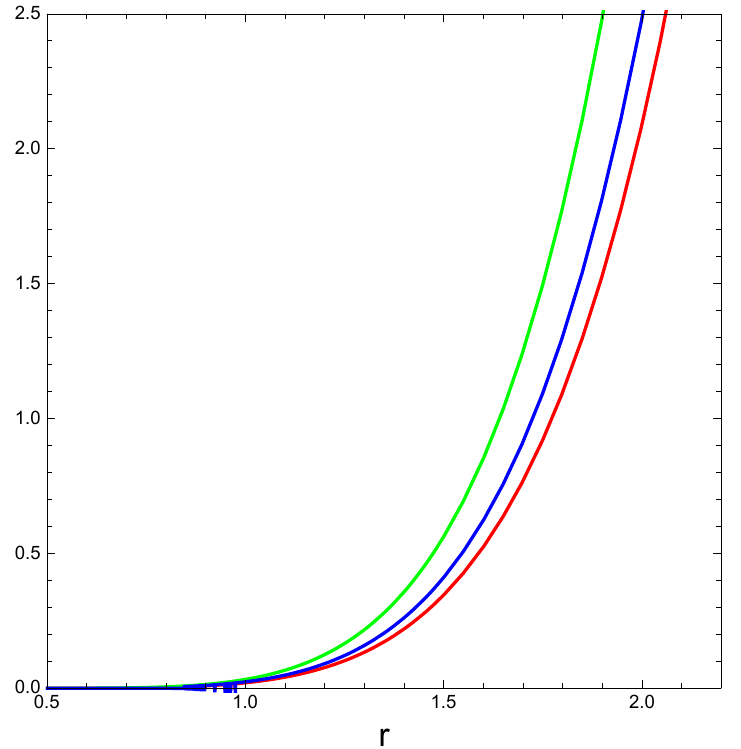
Figure 4. Solution of f ( R ( r )) for R is expressed as an exponential function of radius. The evolution of Equation (8) under f ( R ( r )) gravity is provided. We have fixed the values of a 0 , a 1 , a 2 , K , and C 1 . The red, green, and blue lines correspond to small perturbations of λ 0 , Ψ 0 , η 1 , η 2 , and η 3 ,